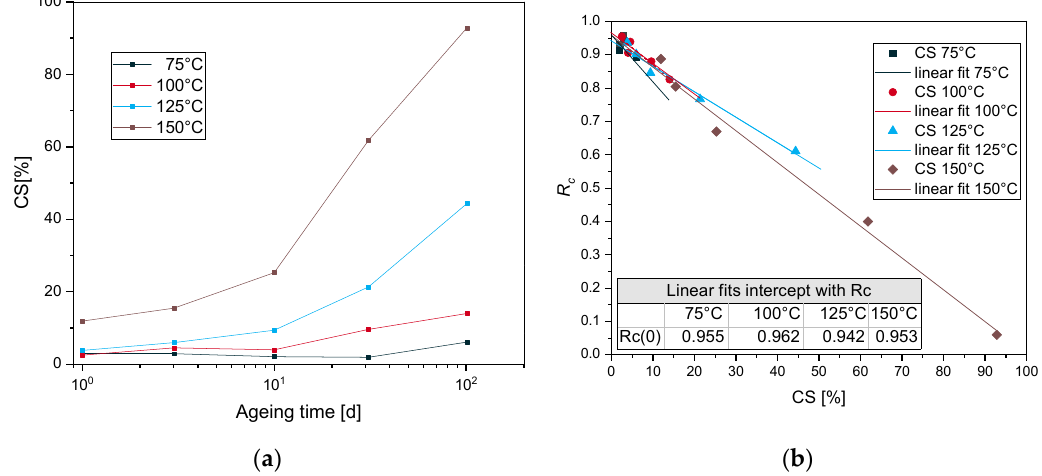
Figure 6. ( a ) CS after tempering versus ageing time for EPDM at different temperatures, ( b ) Initiation times at different temperatures.